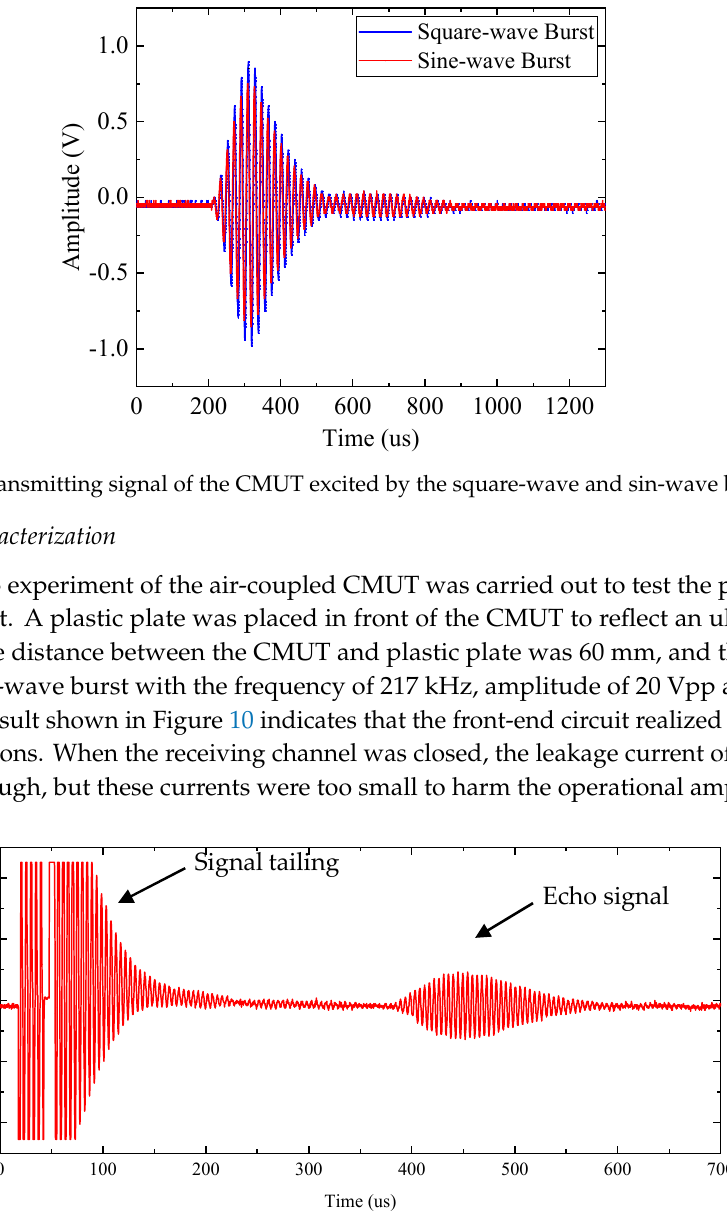
Figure 10. Output signal (echo) of the front-end circuit under five-cycle burst excitation.